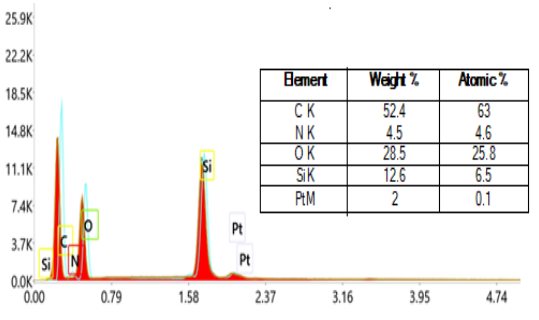
Figure 3. EDX spectra for APDMS-CL.